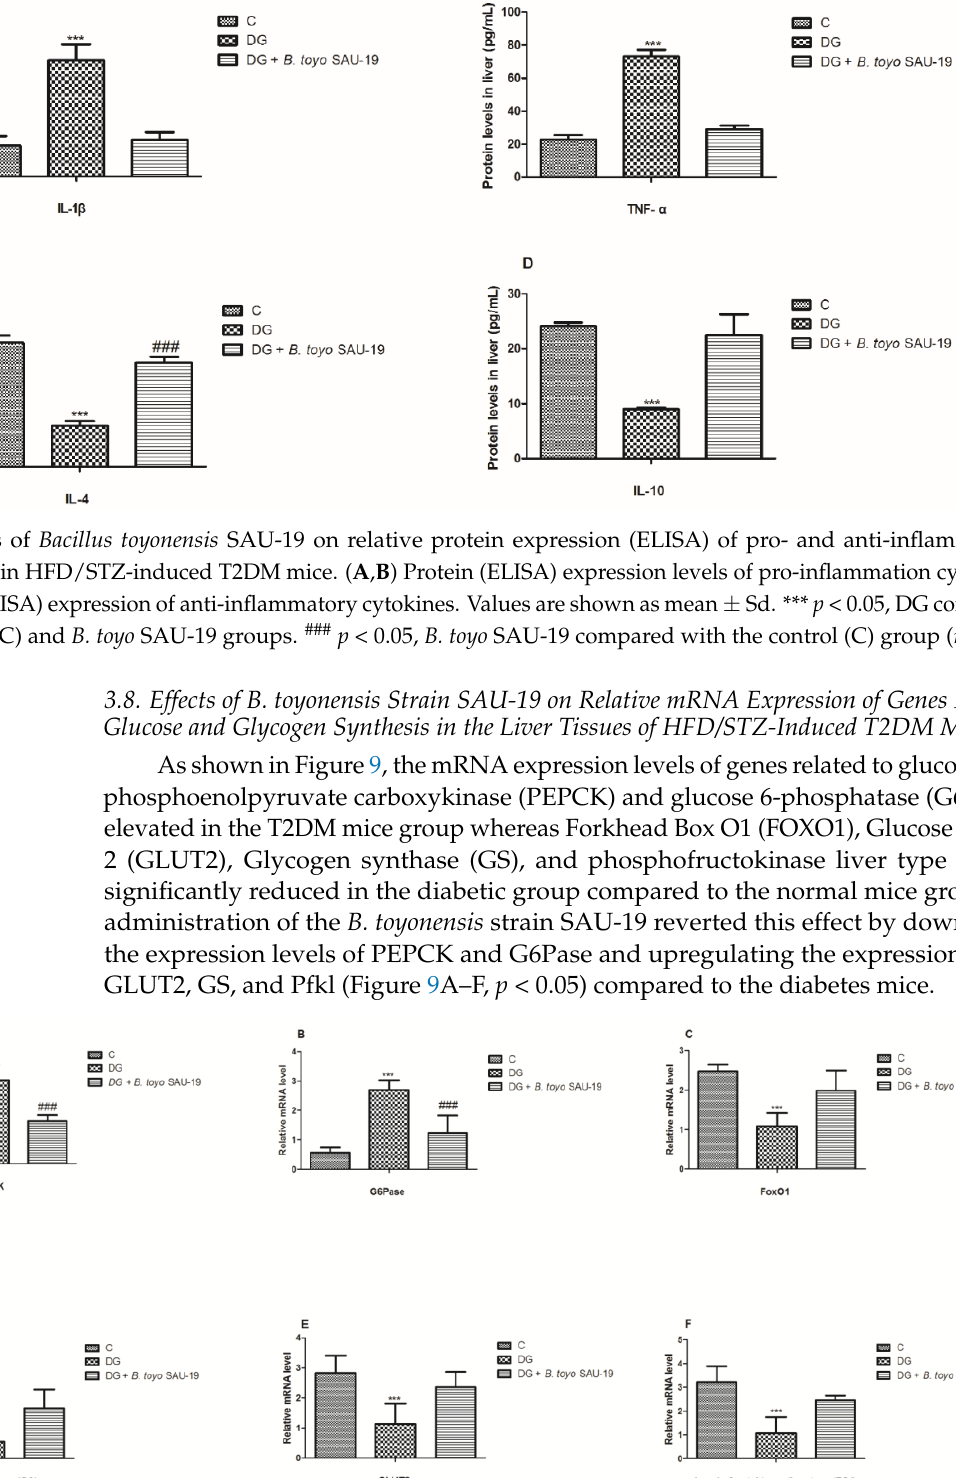
Figure 7. Effects of Bacillus toyonensis SAU-19 on relative mRNA expression of pro- and anti-inflammation-related cyto- kines in HFD/STZ-induced T2DM mice. ( A , B ) mRNA expression levels of pro-inflammation cytokines. ( C , D ) mRNA ex- pression of anti-inflammatory cytokines. Values are shown as mean ± Sd. Bars with *** are statistically different ( p < 0.05). DG compared with the control (C) and B. toyo SAU-19 groups ( n = 6).